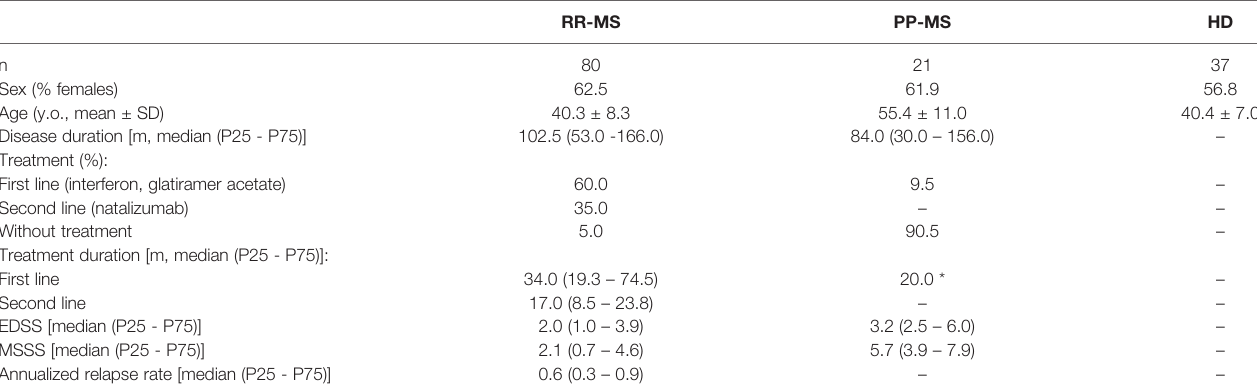
TABLE 1 | Demographic and clinical characteristics of patients and HD included in this